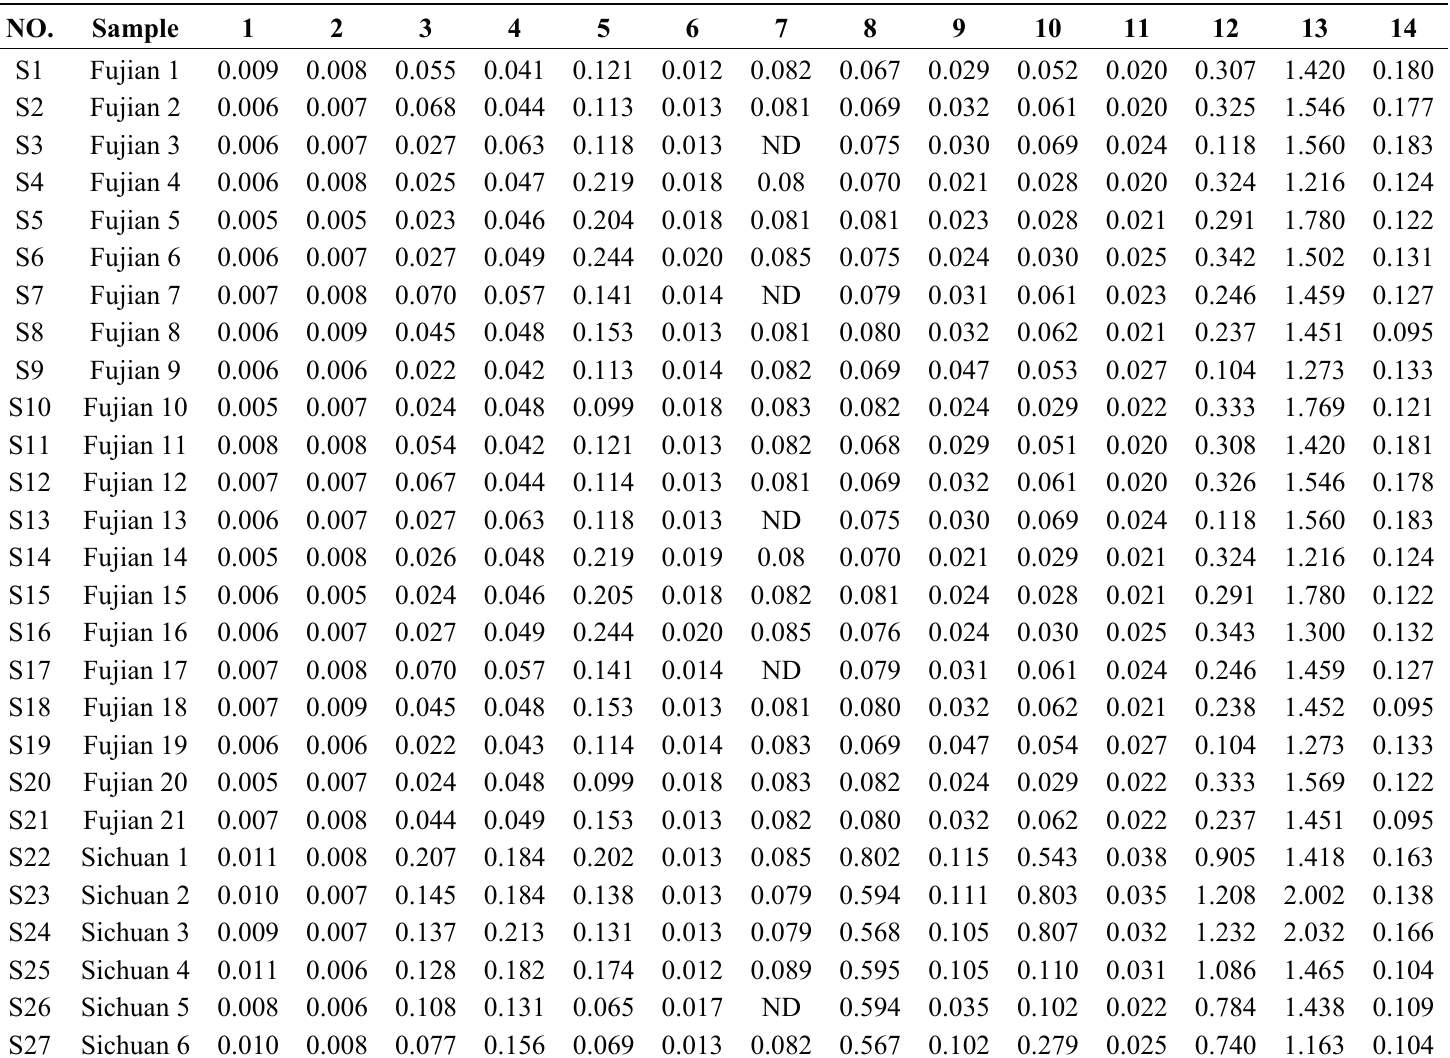
Table 5. Contents (mg/g) of the fourteen triterpenoids in AMR ( n =